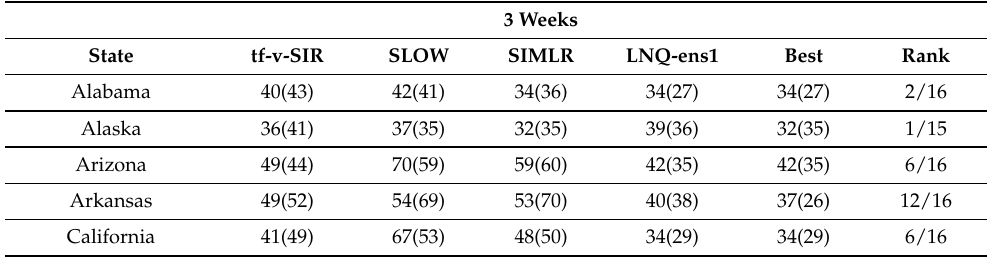
Table A3. Comparison of MAPE between different models across all the states in the US 3 weeks in advance. The number in parenthesis represents the standard deviation of the